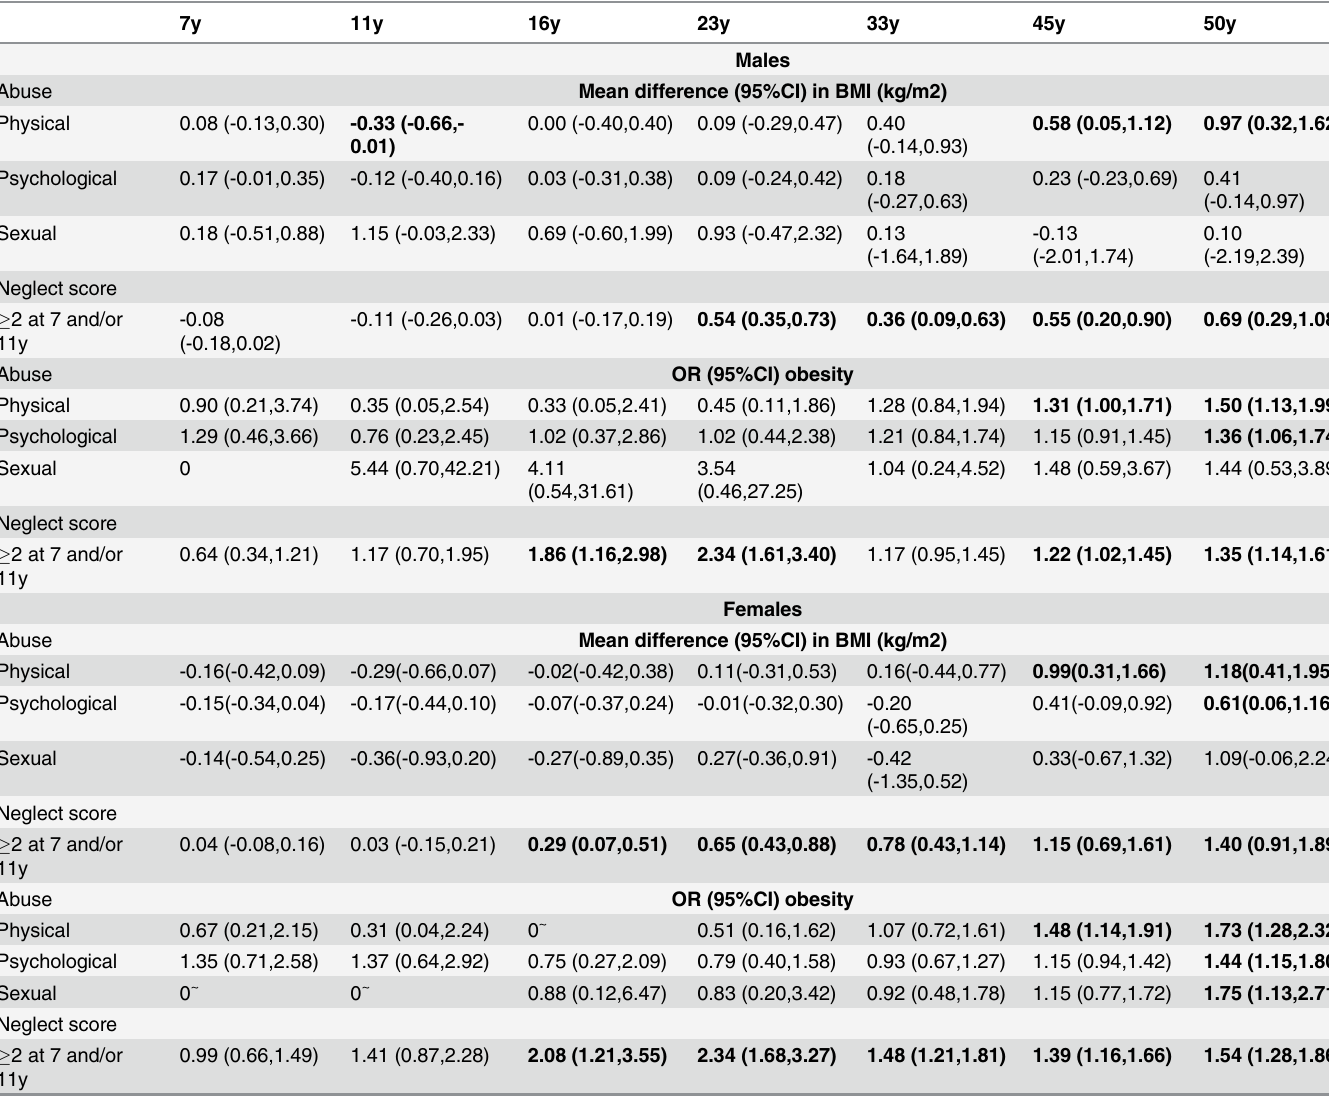
Table 2. Mean difference (95%CI) in BMI (kg/m 2 ) and OR (95% CI) for obesity at each age by childhood maltreatment